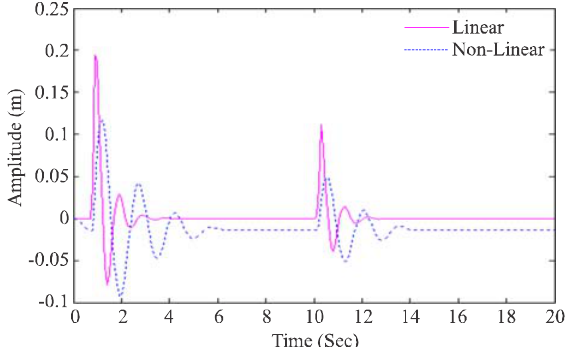
FIG. 9. SPRUNG MASS DISPLACEMENT FOR LINEAR AND NON- LINEAR SYSTEM